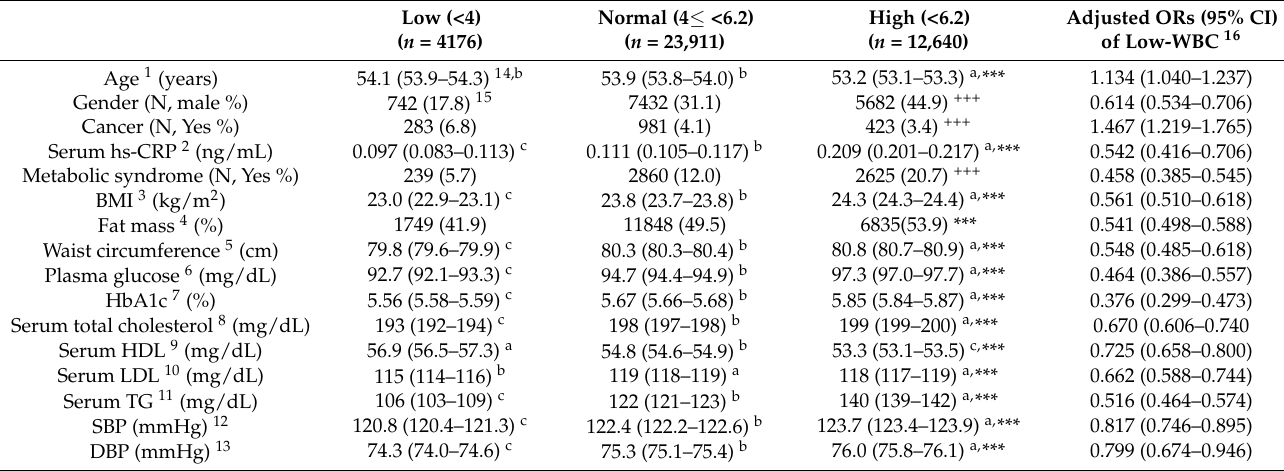
Table 1. Demographic, anthropometric, and biochemical characteristics of the participants according to the contents of white blood cells (WBC) and their adjusted odds ratio (ORs) of low-WBC and 95% confidence intervals